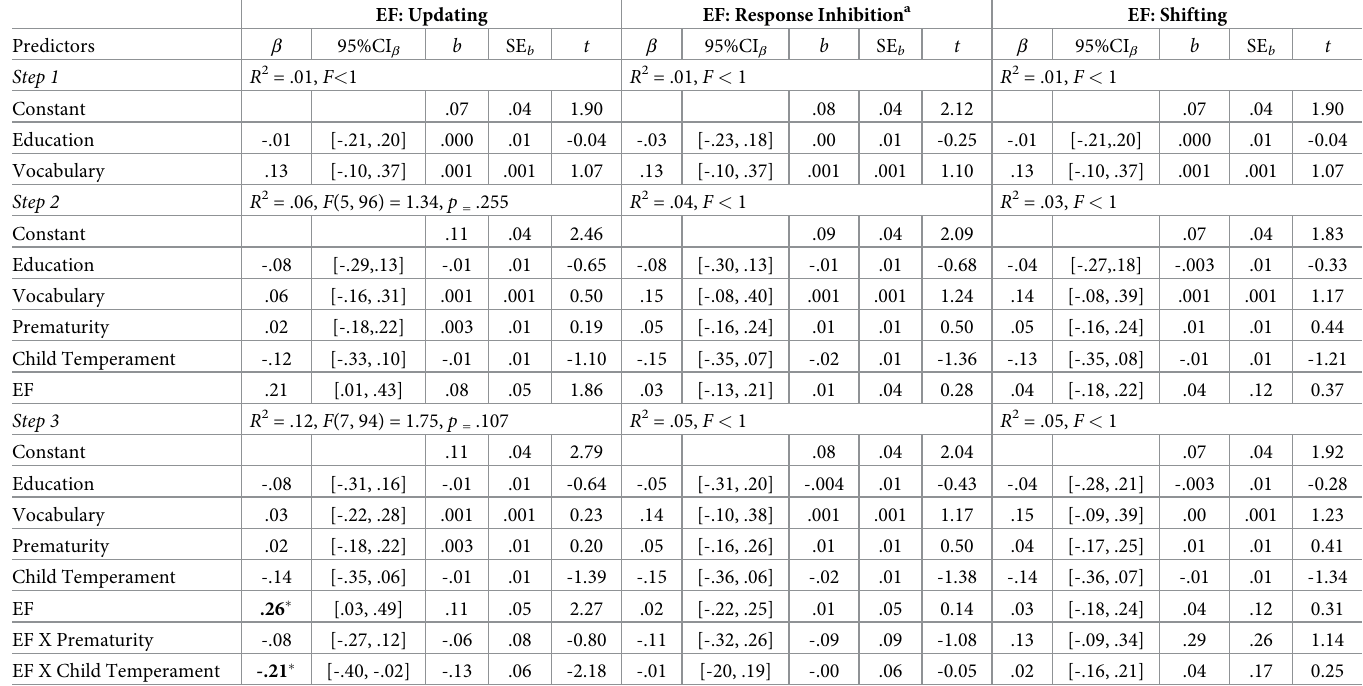
Table 3. Regression analyses for testing executive functions, prematurity, and child temperament in predicting appropriate